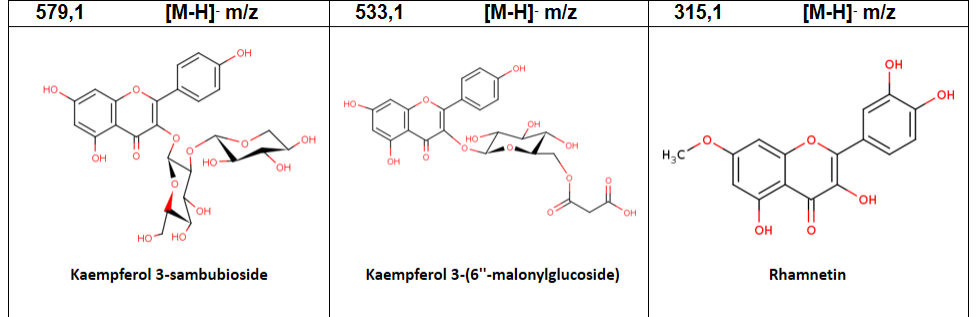
Figure 5. Phenolic compounds identified by LC ‐ MS/MS analysis of aqueous extracts of in vitro plants of A. chilensis . Table 6. Inhibition of bovine aldose reductase (AR) and pancreatic alpha-amylase (AA) enzymes for aqueous extracts of fruit and in vitro plant of A. chilensis and aqueous solutions of the anthocyanins and phenolic compounds standards. Mean ± standard